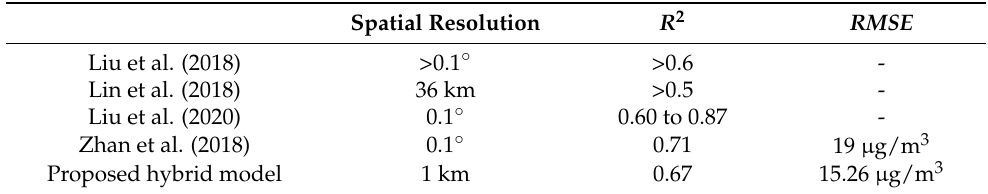
Table 3. Comparison with other’s